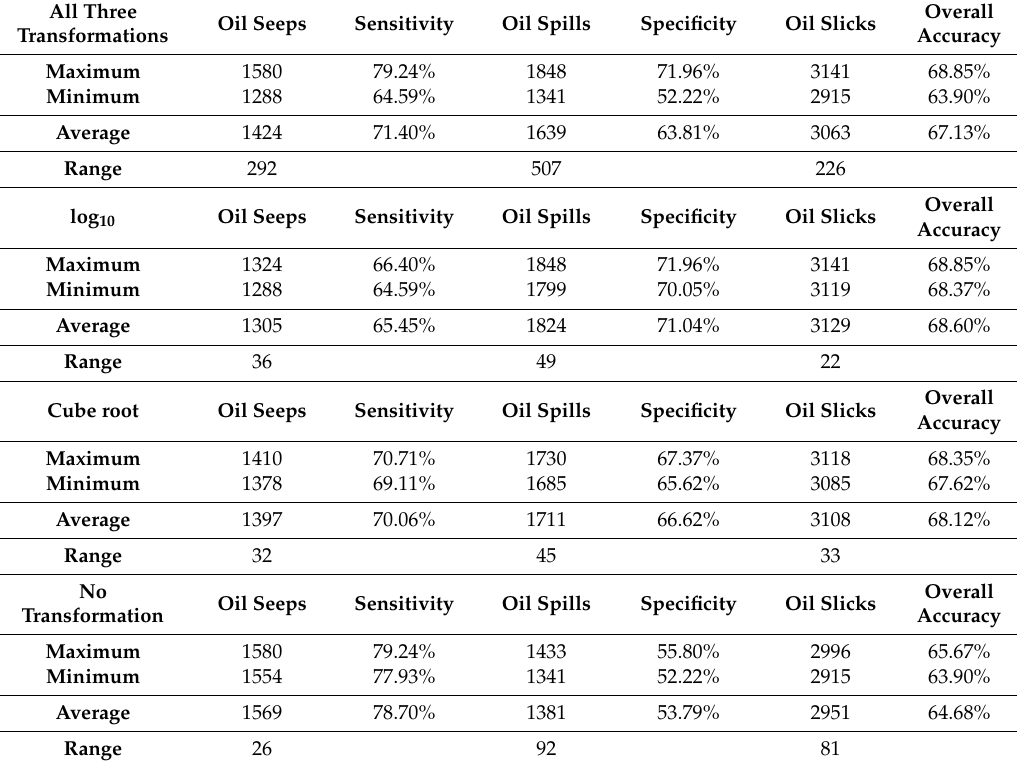
Table 6. Statistics summary of our linear discriminant analyses (LDAs) based on the major blocks